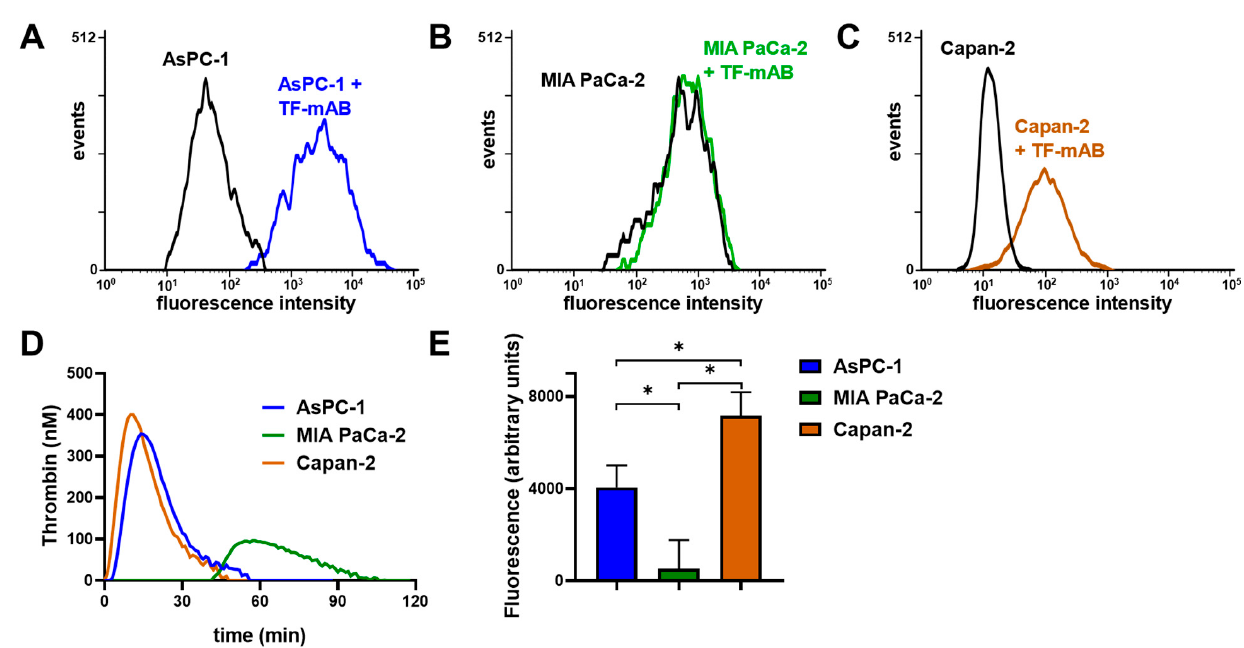
Figure 4. TF and P-selectin ligand determination on AsPC-1, Capan-2, and MIA PaCa-2 cells. Quantification of TF expression by flow cytometry on ( A ) AsPC-1, ( B ) MIA PaCa-2, and ( C ) Capan-2 cells. AsPC-1 and Capan-2 cells exhibited a pronounced TF expression whereas MIA PaCa-2 cells revealed hardly any expression. ( D ) Thrombin generation of AsPC-1, Capan-2, and MIA PaCa-2 cells was determined in platelet-rich-plasma without recalcification. ( E ) Quantification of P-selectin ligand expression was determined with a P-selectin adhesion assay for AsPC-1, Capan-2, and MIA PaCa-2 cells. AsPC-1 and Capan-2 exhibited an enhanced binding to immobilized, recombinant human P-selectin compared to MIA PaCa-2 cells. Figures ( A − D ) illustrate representative data of at least five identical experiments. Data of the static adhesion assay ( E ) are means of at least n = 5 (±SD), asterisks indicate statistical significance: * p < 0.05.